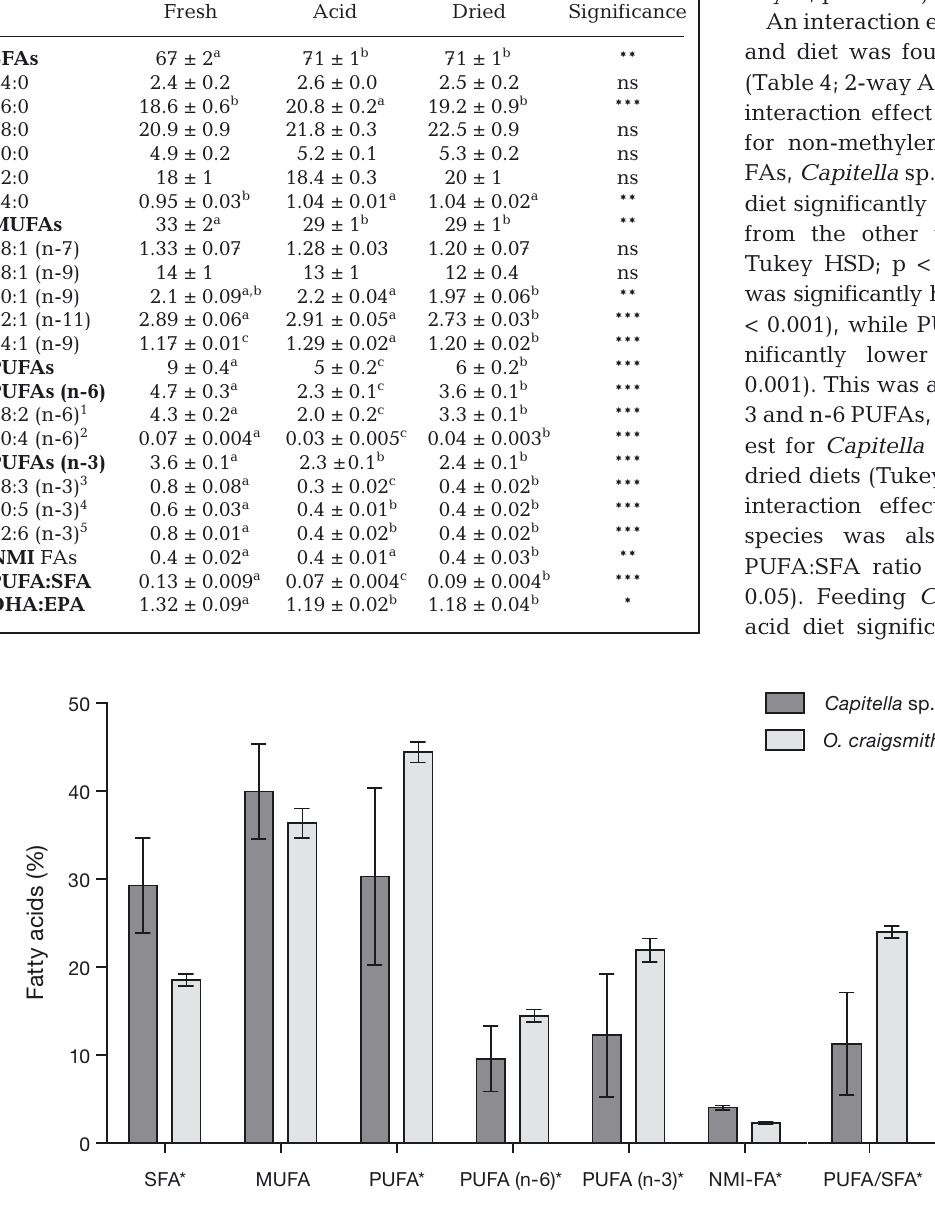
Fig. 3. FA classes (% of total FAs) and ratios (polyunsaturated [PUFA]: sat urated FA [SFA] and docosahexaenoic [DHA]:eicos- apentaenoic acid [EPA]) per polychaete species ( Capitella sp. and Ophryotrocha craigsmithi ). Bars are mean values (n = 12 samples for Capitella sp. and 10 samples for O. craigsmithi) ; error bars are SD. FA classes or ratios with an asterisk are signifi- cantly different between the 2 polychaete species (p < 0.05). All FAs (>0.1% of total FAs) were used to calculate the sum of SFAs, monounsaturated FAs (MUFAs), PUFAs, n-6 and n-3 PUFAs or non-methylene interrupted (NMI)